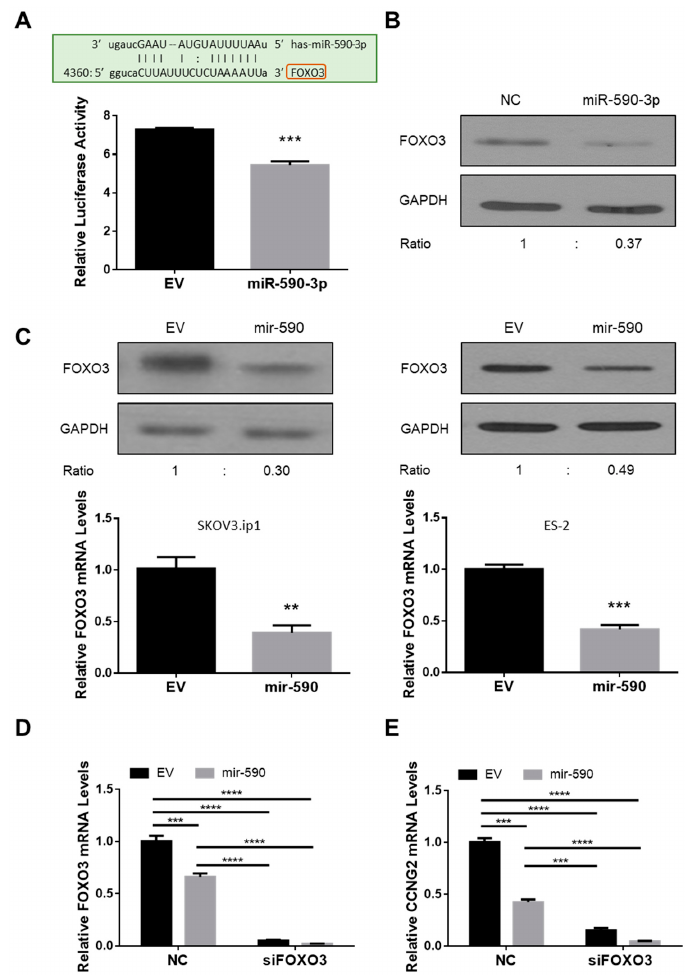
Figure 2. miR-590-3p targeted FOXO3 . ( A ) A predicted miR-590-3p binding site was found in FOXO3 3 ʹ UTR (top). A luciferase reporter assay showed that mir-590-3p significantly decreased the luciferase 3 (cid:48) UTR (top). A luciferase reporter assay showed that mir-590-3p significantly decreased the luciferase activity in ES-2 cells (bottom). ( B ) miR-590-3p decreased the protein level of FOXO3 in SKOV3.ip1 activity in ES-2 cells (bottom). ( B ) miR-590-3p decreased the protein level of FOXO3 in SKOV3.ip1 cells. ( C ) In SKOV3.ip1 and ES-2 cells stably transfected with mir-590, both the mRNA and protein cells. ( C ) In SKOV3.ip1 and ES-2 cells stably transfected with mir-590, both the mRNA and protein levels of FOXO3 were lower than control cells transfected with an empty vector (EV). ( D ) ES-2 cells were transfected with siRNA targeting FOXO3. In siFOXO3 transfected cells, FOXO3 mRNA levels levels of FOXO3 were lower than control cells transfected with an empty vector (EV). ( D ) ES-2 cells were significantly down-regulated. (E) Silencing of FOXO3 reduced CCNG2 mRNA level in ES-2. were transfected with siRNA targeting FOXO3. In siFOXO3 transfected cells, FOXO3 mRNA levels Data represent the mean ± SEM ( n = 3). Statistical analyses were performed using Student’s t-test (A were significantly down-regulated. (E) Silencing of FOXO3 reduced CCNG2 mRNA level in ES-2. Data and C), or two-way ANOVA/Student–Newman–Keuls test (D and E). ** p < 0.01, *** p < 0.001, **** p < represent the mean ± SEM ( n = 3). Statistical analyses were performed using Student’s t-test (A and C), 0.0001. or two-way ANOVA/Student–Newman–Keuls test (D and E). ** p < 0.01, *** p < 0.001, **** p <